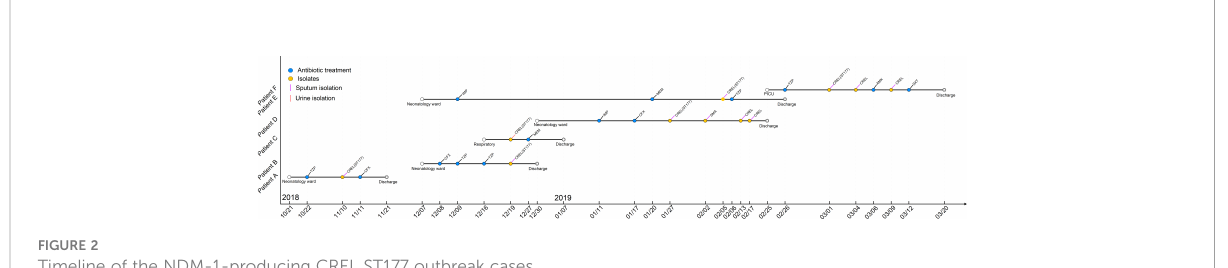
FIGURE 2 Timeline of the NDM-1-producing CREL ST177 outbreak